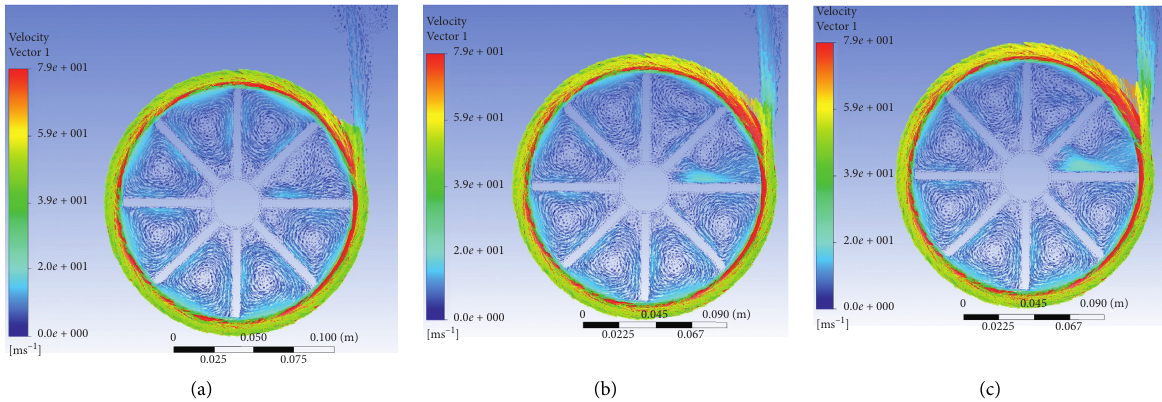
Figure 7: The vector distribution without inducer at different flow rates. (a) Q